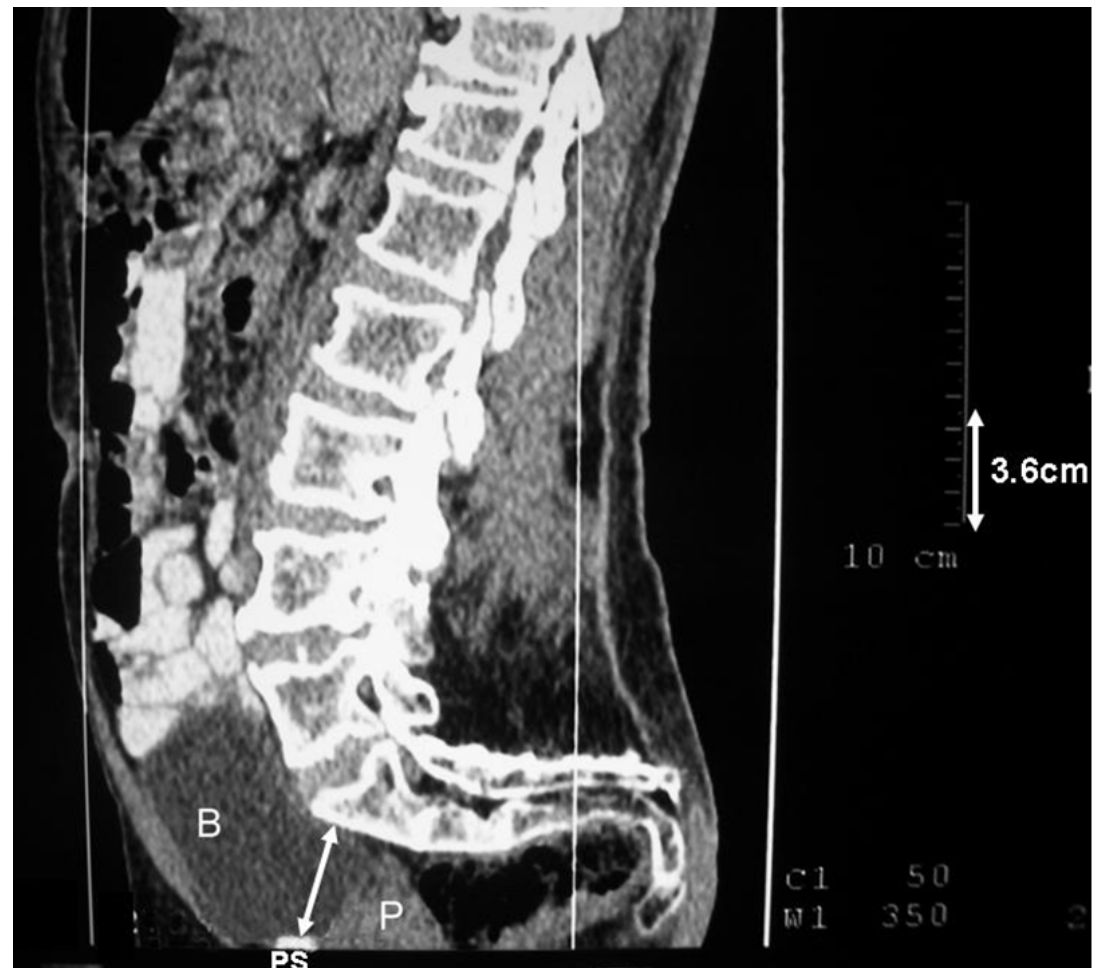
FIGURE 2. Saggital computed tomography scan section of the same ACH patient highlighting the bony anatomy, with the narrow anteroposterior dimension (arrow), and a distorted bladder (B) and prostate (P) behind the pubic symphysis (PS).